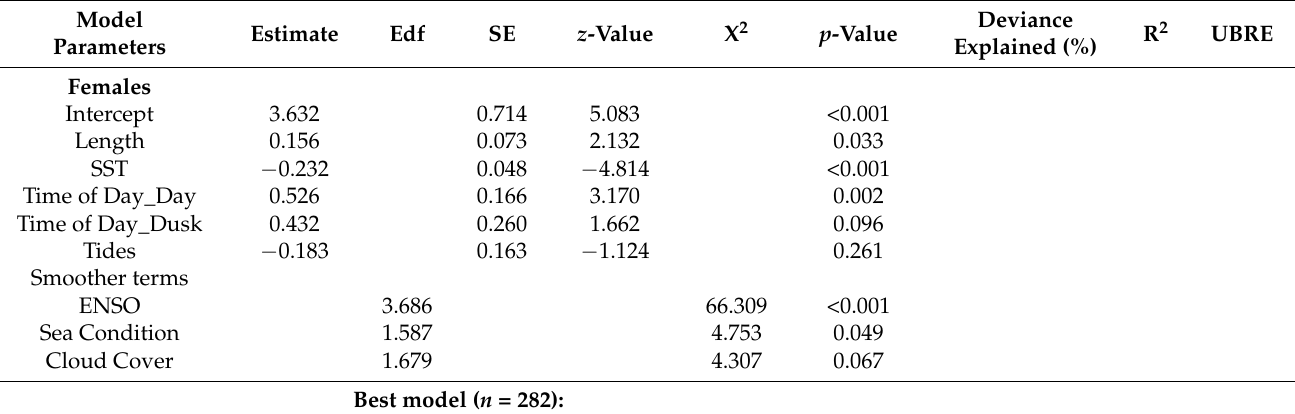
Table 2. Results from the backward selection of GAM models with the explanatory variables and their significance for the model. p -values of less than 0.05 were regarded as statistically